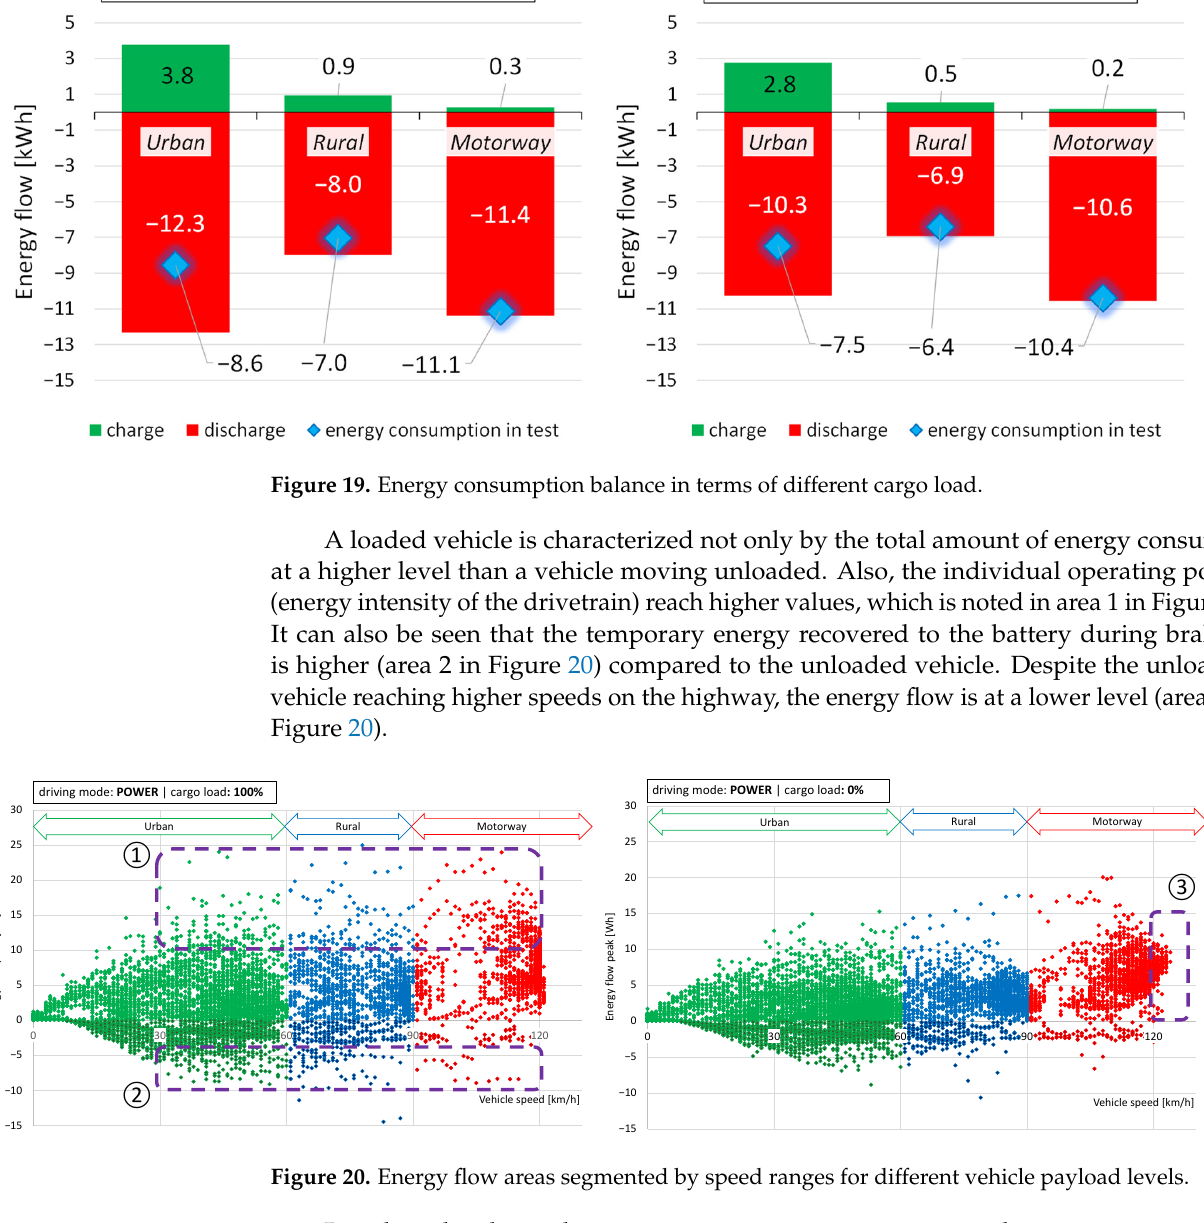
Figure 20. Energy flow areas segmented by speed ranges for different vehicle payload levels.